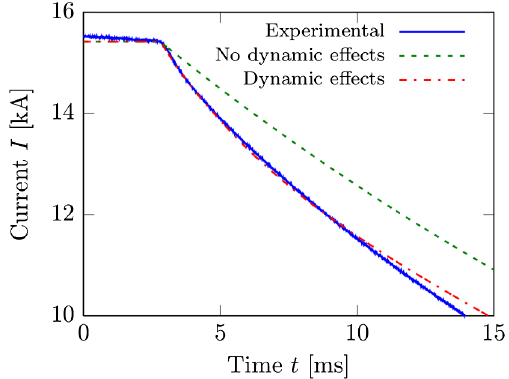
FIG. 8. Short model coil and magnet current decay compared with computed decays without and with dynamic